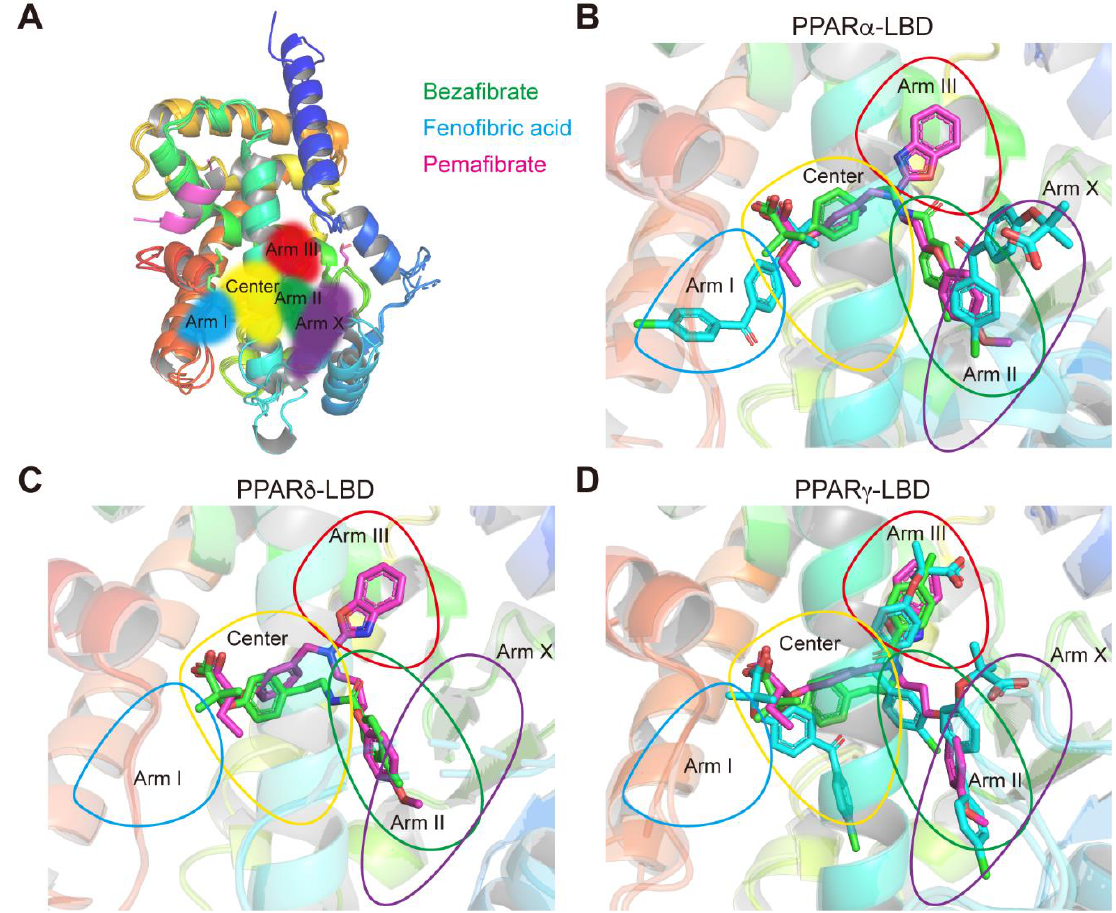
Figure 7. Ligand-binding pocket (LBP) regional localization of the three fibrates in PPAR α / δ / γ -LBD. ( A ) LBP comprising the Center and Arms I–III and X of PPAR α / δ / γ -LBD [6,17]. ( B – D ) Superimposed images of bezafibrate (green), fenofibric acid (blue), and pemafibrate (red) in PPAR α / δ / γ